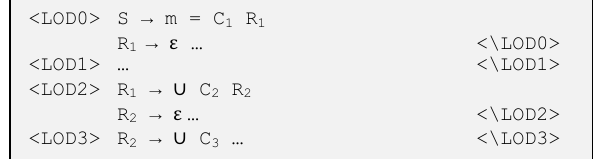
Figure 6. Final production rules after second